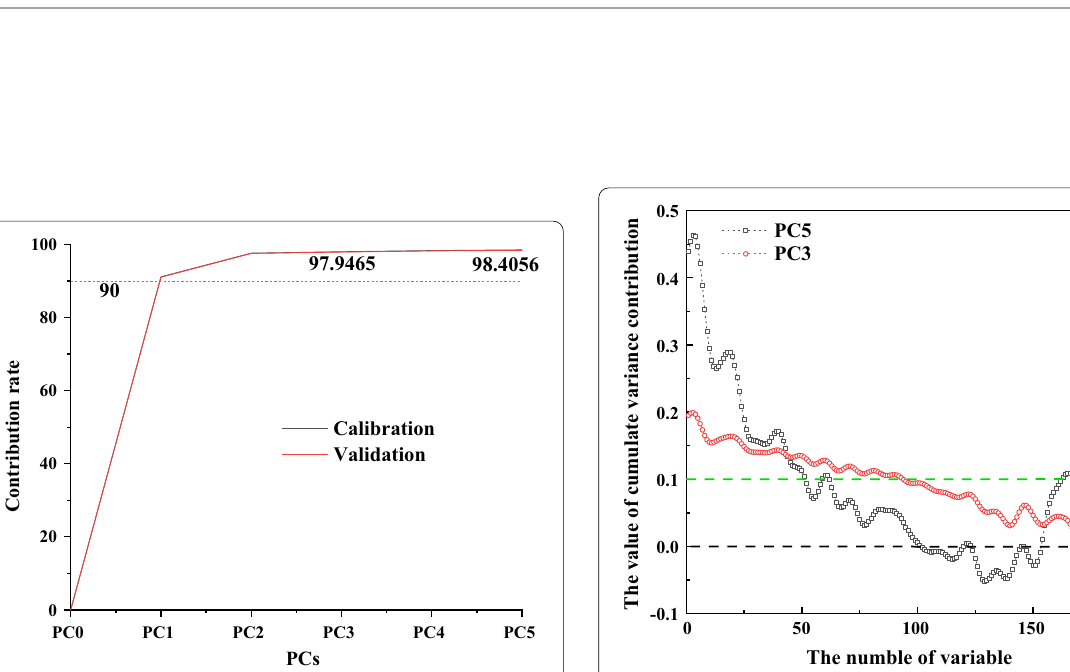
Fig. 3 Contribution rate of cumulative variables Fig. 4 Calculation of cumulative variance contribution of